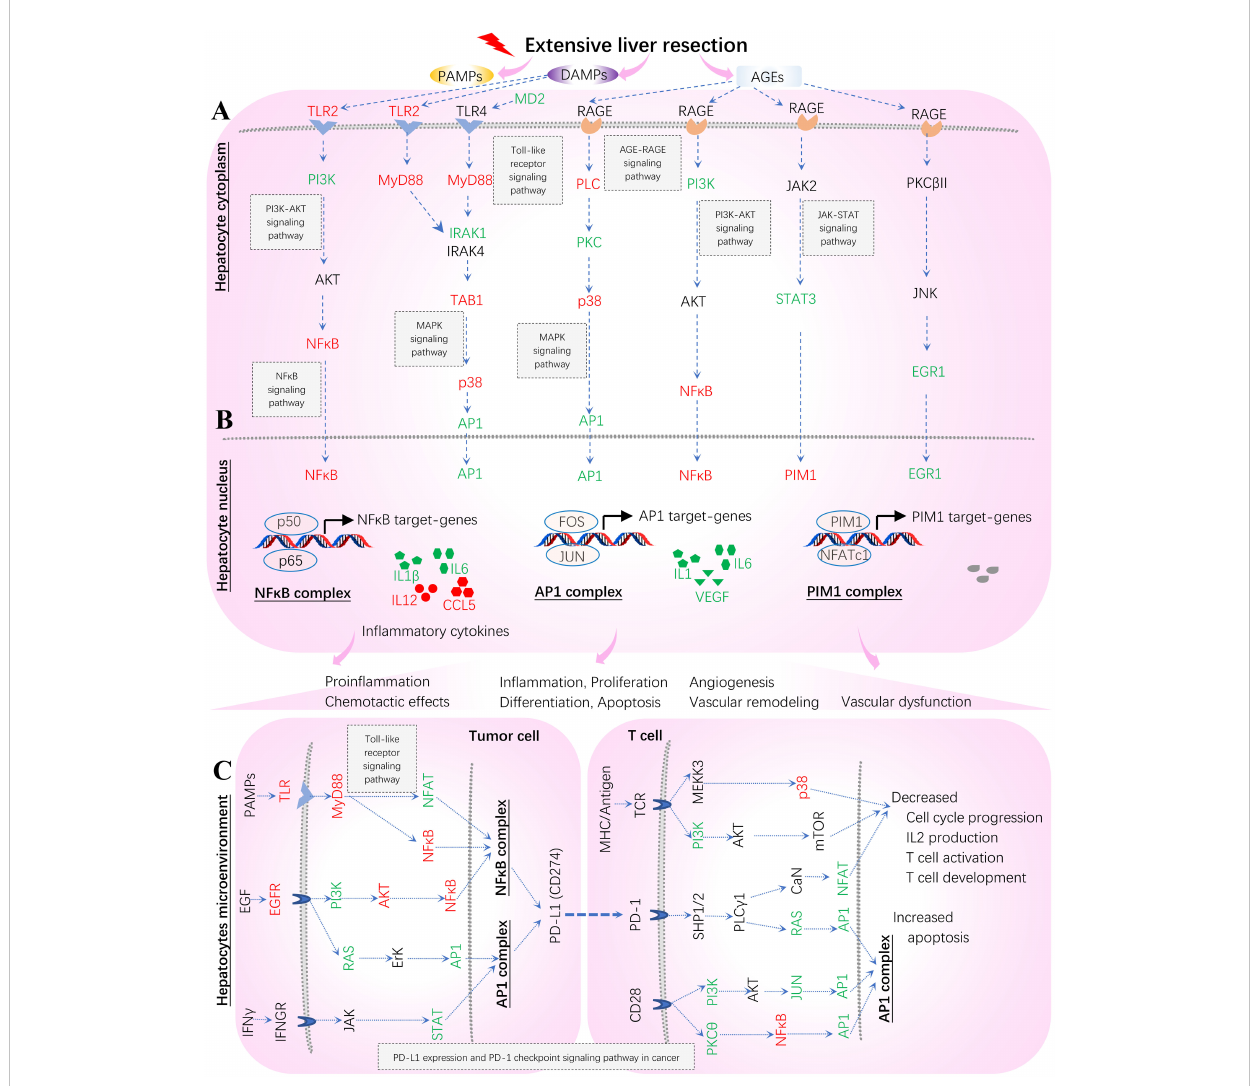
FIGURE 13 Hypothetical mechanisms underlying systems immunology triggered by extensive hepatectomy 2 hours post-resection in liver remnants. Key regulators are up (red)- and down (green)-regulated and marked on the indicated signaling axis coupled with target TPKO signaling pathways. These regulators coordinate MyD88 ( Myd88 ) vs. RAGE ( Ager ) signaling transduction, thus orchestrating the regulation of innate in fl ammatory responses at the systems-level. The MyD88 signaling pathway responsible for proin fl ammatory responses is essential for survival consequent to 85% resection of the liver. MyD88 action stimulates the activation of NF k B and the subsequent up-regulation of key genes (including IL6) involved in liver regeneration responses. In contrast, RAGE opposes the actions of MyD88 signaling by suppressing NF k B, thereby reducing the activation of NF k B and the consequent production of cytokines (including IL1, IL1 b , IL6, IL12 and CCL5), and by suppressing IL6-mediated phosphorylation of STAT3, which down-regulates PIM1 and reduces hyperplastic responses. The AP1 complex (FOS and JUN) acts as a hub in the present study. (A) Hepatocyte cytoplasm; (B) Hepatocyte nucleus; (C) Hepatocytes microenvironment (Tumor cells and T